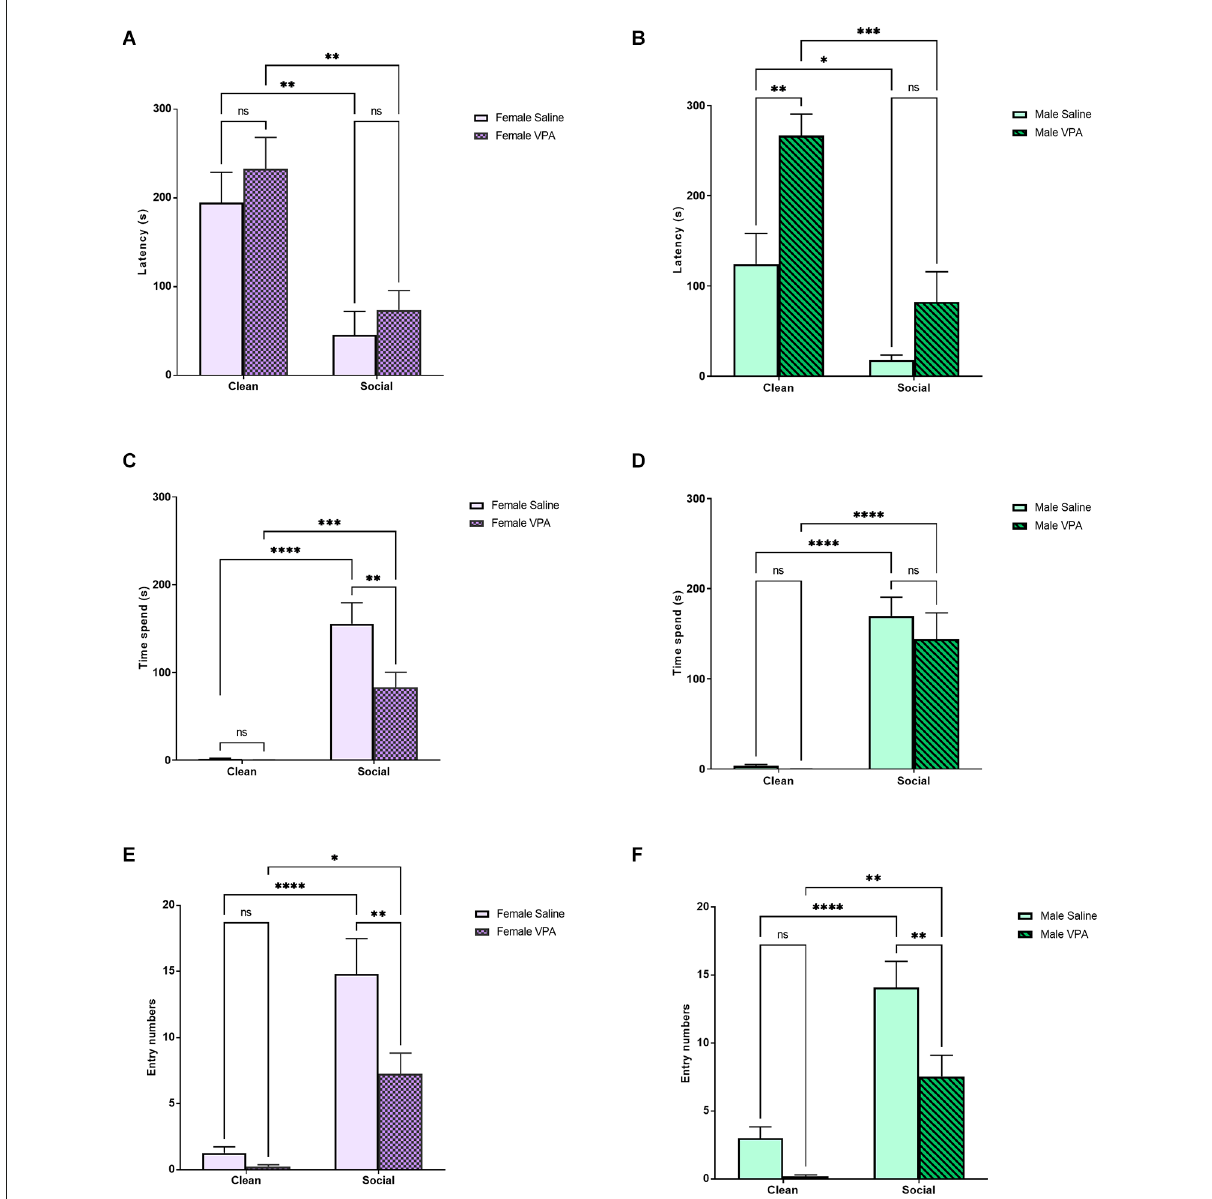
FIGURE2 (A,B) P6–7 Sex differences: latency to enter zones. Data expressed as mean ± standard error of the mean. We observed a significant main effect of bedding type in females (A) , p < 0.0001, and males (B) , p < 0.0001. There was a significant main effect of drug exposure in males alone, p = 0.003. (C,D) P6–7 Sex differences: time spent in zones. Data expressed as mean ± standard error of the mean. We observed a significant main effect of bedding in both females (C) , p < 0.0001, and males (D) , p < 0.0001. In females, we also observed a significant main effect of drug exposure, p = 0.015, and a significant interaction, p = 0.02. Female VPA-exposed pups spent significantly less time in the SB zone than female saline-exposure pups, p = 0.005. (E,F) P6–7 Sex differences: number of zone entries. Data expressed as mean ± standard error of the mean. We observed significant main effects of bedding type and drug exposure in females (E) , p < 0.0001 and p = 0.008, and males (F) , p < 0.0001 and p = 0.0013. There was also a significant interaction in females, p = 0.04. Both female, p = 0.006, and male, p = 0.0075, VPA-exposed pups made significantly fewer entries into the SB zone. ∗ p = 0.01–0.05; ∗∗ p = 0.001–0.01; ∗∗∗ p = 0.0001–0.001; ∗∗∗∗ p < 0.0001; ns = p >